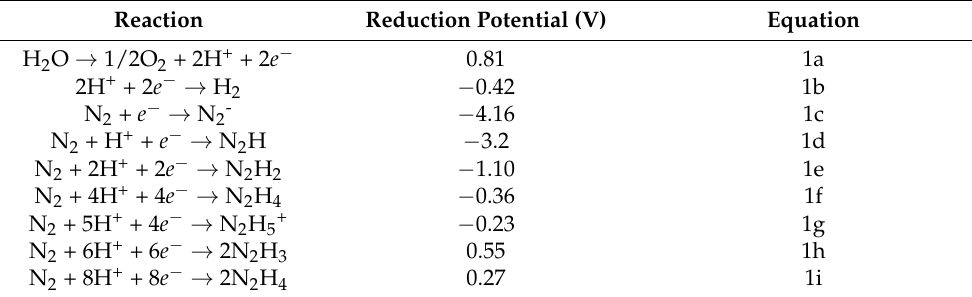
Table 1. Nitrogen hydrogenation reaction and reduction potentials (vs. NHE at pH = 0).